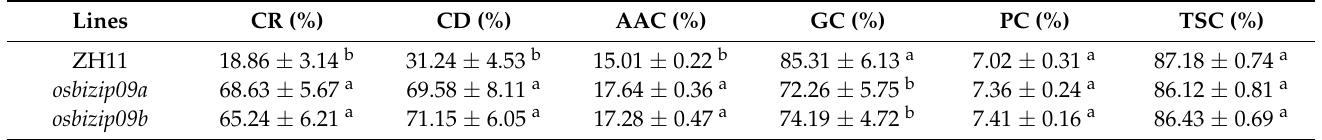
Figure 1. Grain appearance and SEM images of rice endosperm cross-sections. ( A , B ) represent milled rice grain appearance; ( C–K ) represent ZH11, osbzip09a , and osbzip09b , respectively; ( D , G , J ) represent the SEM micrographs of the transparent region of a rice endosperm; ( E , H , K ) represent the SEM micrographs of the chalky region of rice endosperm. Table 1. Physicochemical characteristics and cooking properties of milled rice a .